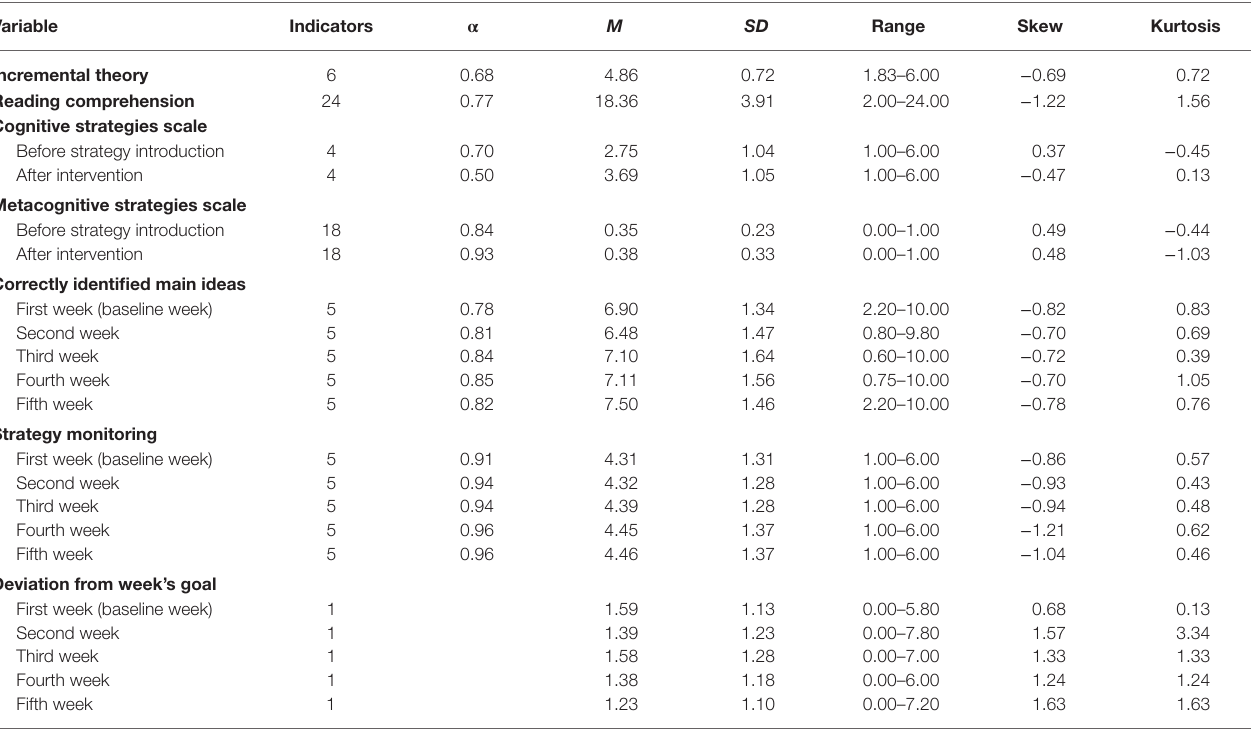
TABLE 1 | Psychometric properties of all variables.